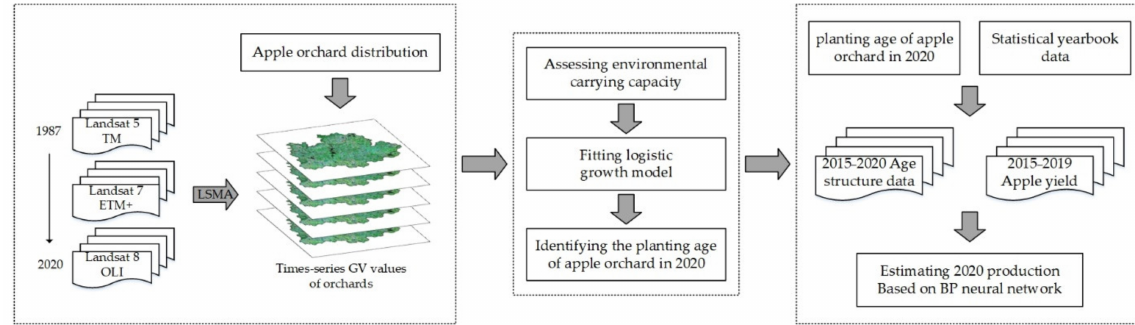
Figure 2. Overall framework of the